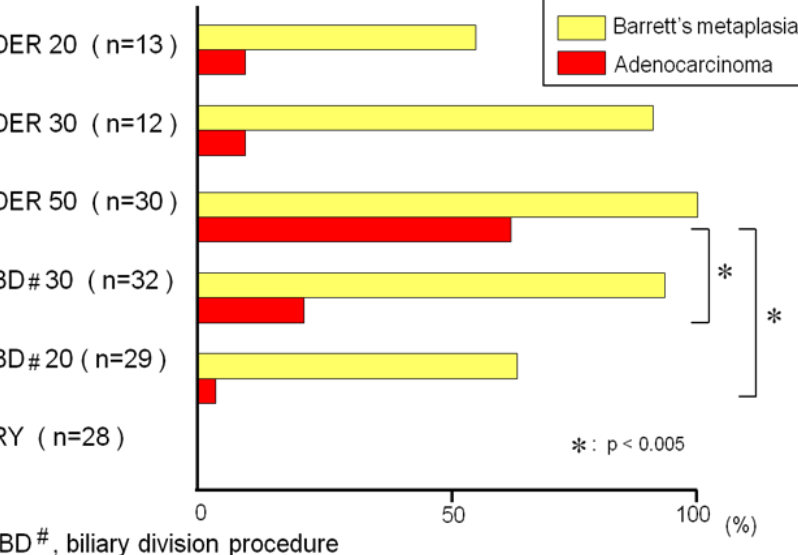
Figure 9. There was no difference in the incidence of Barrett’s metaplasia between the animals sacrificed at week 20th (54%) or 30th (92%) in the DER model and the animals undergoing biliary diversion procedure at week 20th (62%) or 30th (94%). But the incidence of adenocarcinoma was significantly lower in the rats that received the biliary diversion procedure after 30 (19%) and 20 weeks (3%) than in the rats that had DER for 50 weeks (60%) (p <